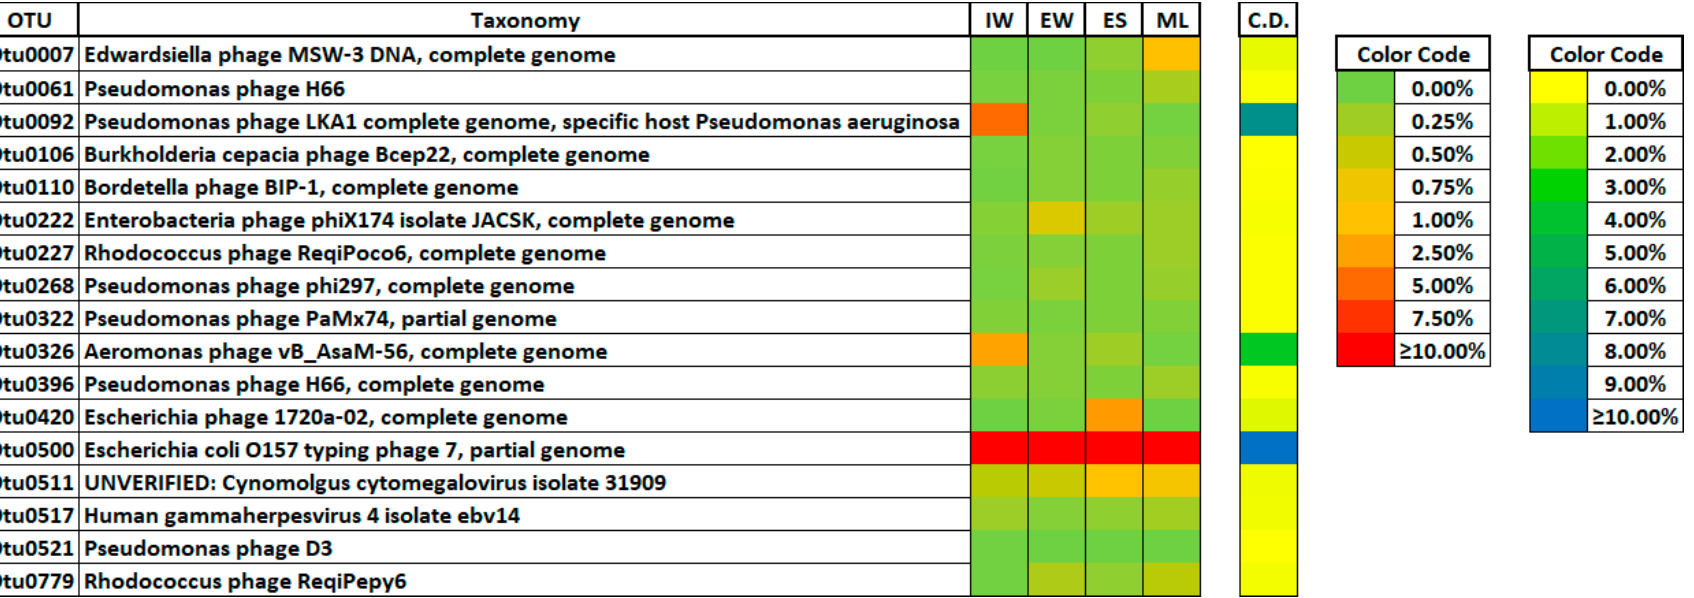
Figure 2. Dominant bacteriophage phylotypes found in different sampling place in a full-scale WWTP. IW: influent wastewater; EW: effluent water; ES: excess sludge; and ML: mixed liquor from the aerobic bioreactor, C.D.: contribution to dissimilarity as per SIMPER.